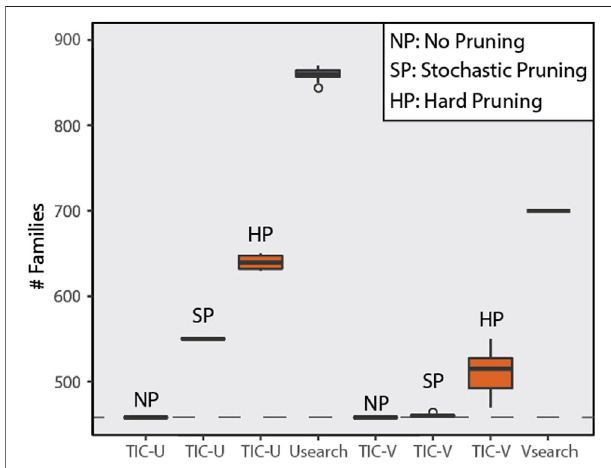
FIGURE 6 | Comparison of the three tools in regards to predicted family number on the LTP dataset under different con fi gurations. TIC was executed containing USEARCH (TIC-U) and VSEARCH (TIC-V) as the integrated clustering tool, with different modes of taxonomic pruning of the input sequences. These tools were also executed as standalone. The dashed line represents the actual number of families in the dataset. USEARCH performs worse in terms of in fl ation of predicted family level clusters, with VSEARCH resulting in only moderate in fl ation. TIC re fl ects this trend in its operation depending on the tool utilized, especially with hard pruning (compete for removal of assignments for whole taxonomic branches). For soft (stochastic)